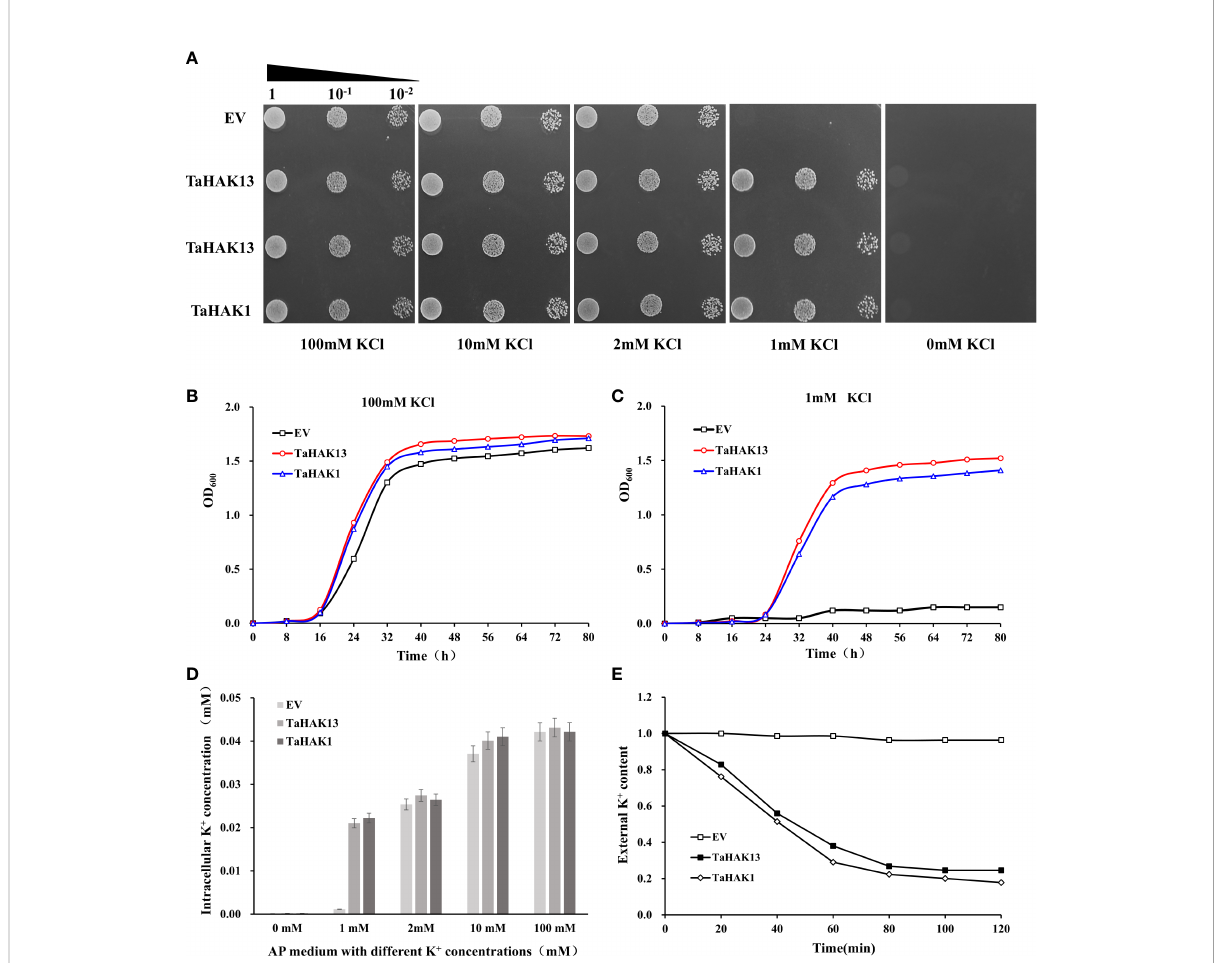
FIGURE 5 TaHAK13 complementarity analysis in a Trk1 and Trk2 K + uptake system de fi cient yeast strain (A) Growth of mutant CY162 in AP-U solid media with different concentrations of K + . CY162 was transformed with the empty vector p416 (EV), TaHAK13 -p416 (TaHAK13), or TaHAK1 -p416 (TaHAK1). After serial dilution, each strain was added to an agar plate for culture. (B) Growth curves for CY162 transformed with the empty vector, TaHAK13 , or TaHAK1 in AP-U liquid medium supplemented with 1mM K + or 100 mM K + . (C) Determination of the K + content in CY162 transformed with the empty vector p416, TaHAK13 , or TaHAK1 in solid AP-U media with various concentrations of K + . (D) K + depletion experiment in the presence of 1 mM K + in AP-U medium. CY162 (transformed with p416, TaHAK13 , or TaHAK1 ) was subjected to K + starvation for 4 h before beginning the experiment. The K + content in the buffer was measured at intervals of 2